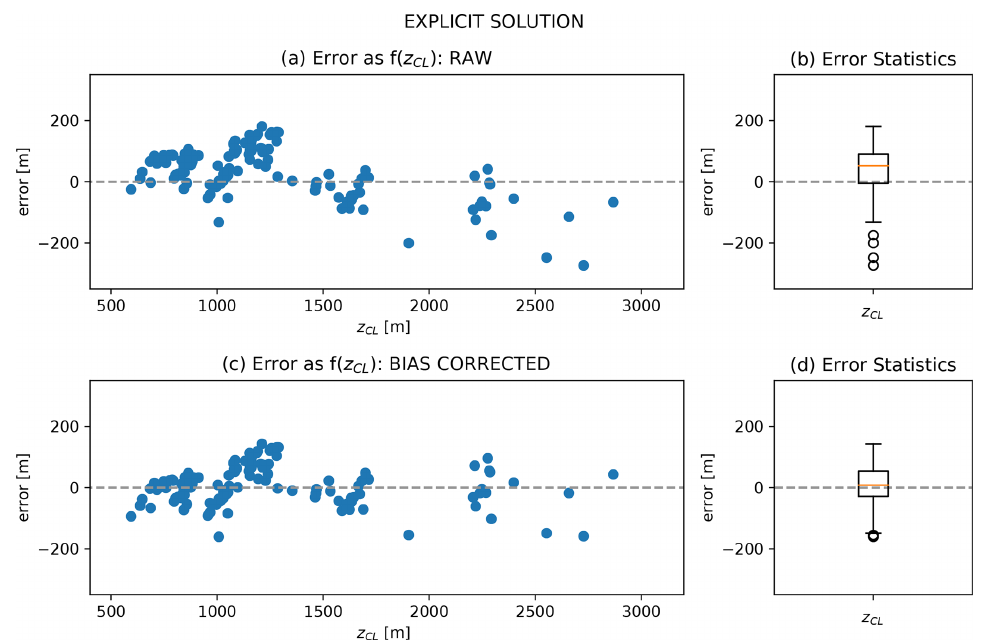
Figure 6. Performance of the smoke injection height parameterization based on the explicit solution (Eq. 9). (a) Non-bias-corrected model prediction error (true – modelled z CL ) as a function of z CL . (b) Error statistics for the non-bias-corrected model. The box and whiskers span interquartile range (IQR) and 1 . 5 × IQR, respectively. Median value is shown in orange. (c) Bias-corrected model prediction error as a function of z CL . (d) Error statistics for bias-corrected